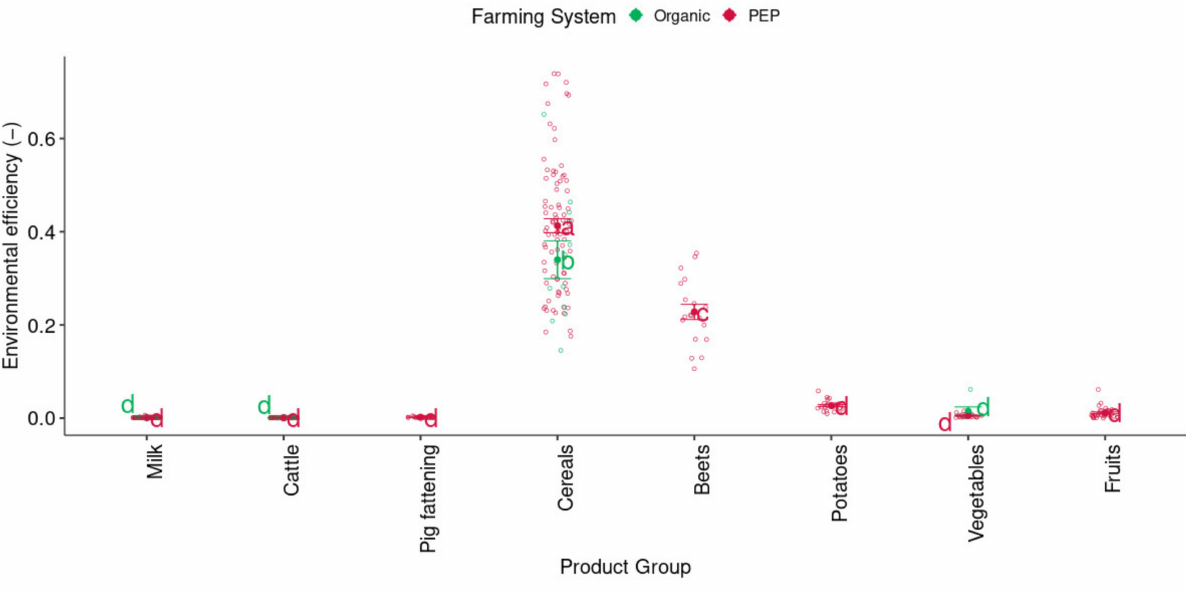
Figure A6. “Environmental efficiency”: Observations, product group means and standard errors and ANOVA results. Significant differences in mean values between product groups are marked with distinct